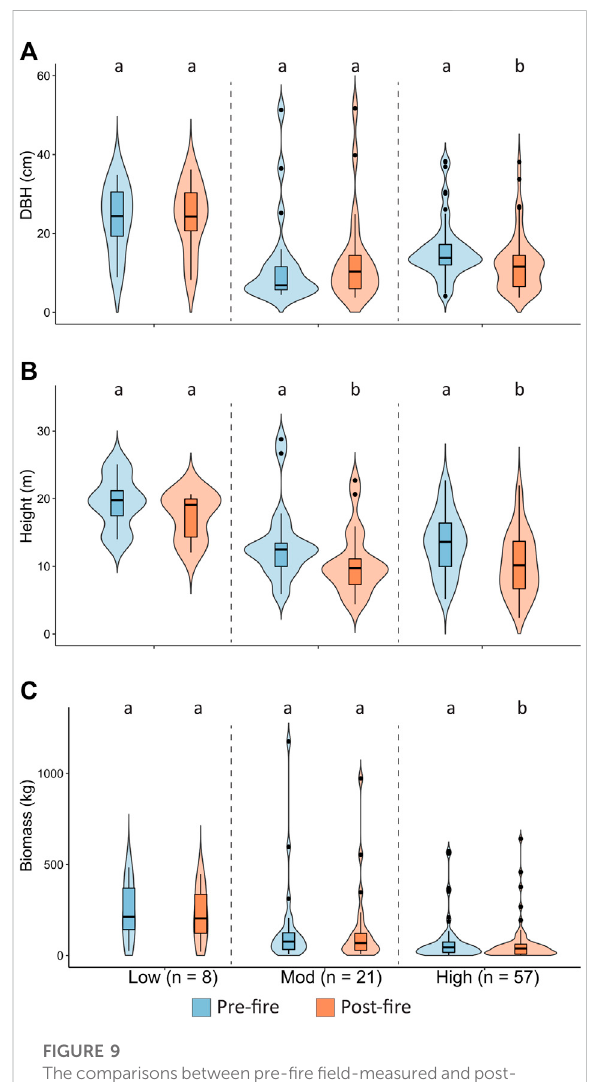
FIGURE 9 Thecomparisonsbetween pre- fi re fi eld-measuredandpost- fi re laser scanning-derived (A) DBH, (B) tree height, and (C) biomass across plot-level burn-severity classes. The violin plots show the data range of each attribute, with the curves representing the probability density distribution, the boxes representing the interquartile range, the bars representing the median, and the dots representing outliers. Signi fi cant differences among medians ( p < 0.05) are indicated with different